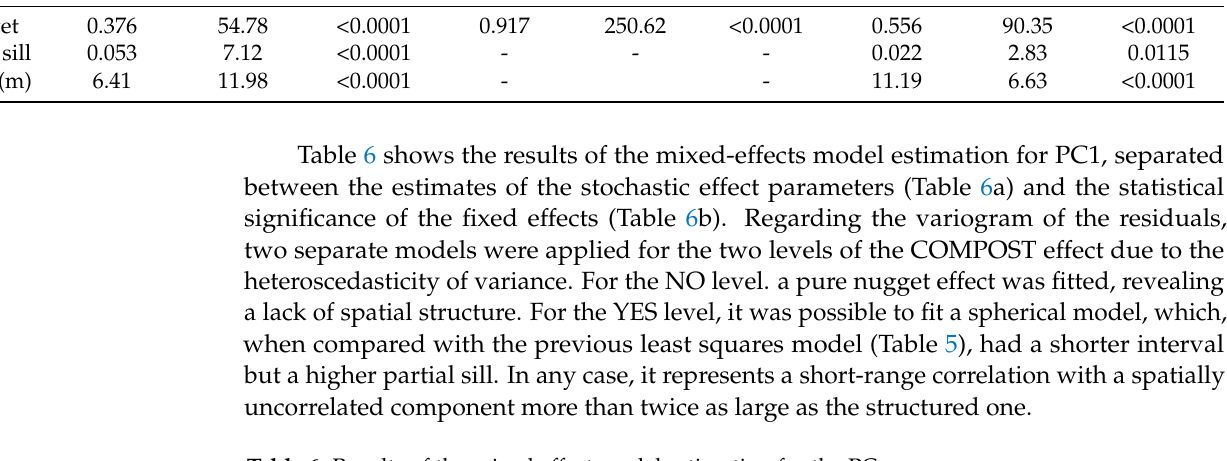
Table 6. Results of the mixed effect model estimation for the